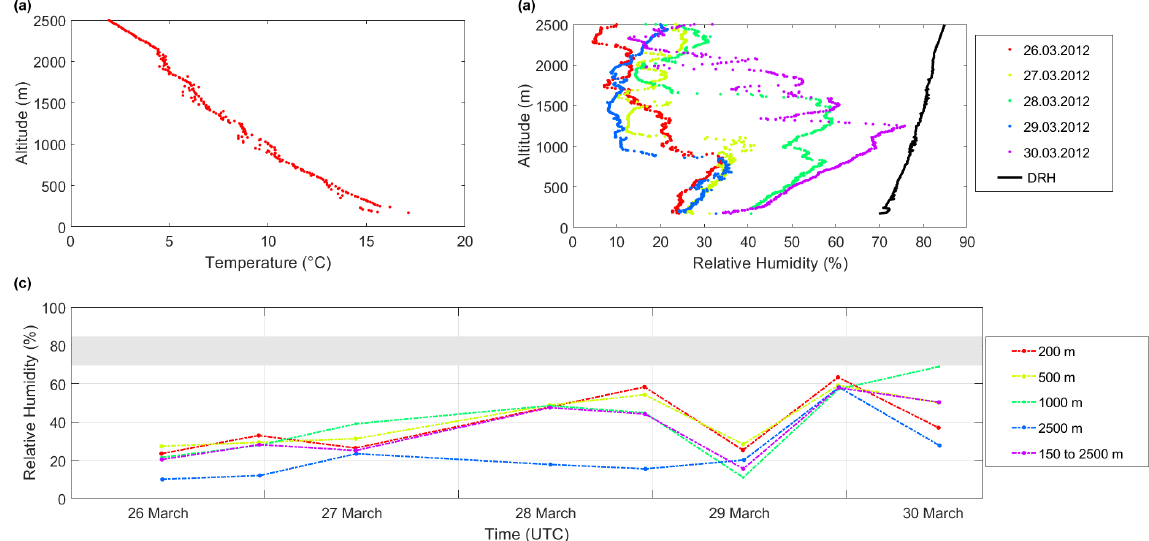
Figure 6. (a) Median temperature ( ◦ C) over the period of interest in the vertical during midday. (b) Relative humidity (%) in the vertical (midday only) from Trappes station and DRH based on the median temperature from (a) . (c) Relative humidity evolution at different heights (average over ± 25m) for all radiosoundings during 26–30 March, whereby the grey bar indicates the DRH lowest and highest values corresponding to 170 and 2500m altitude. DRH refers to deliquescence relative